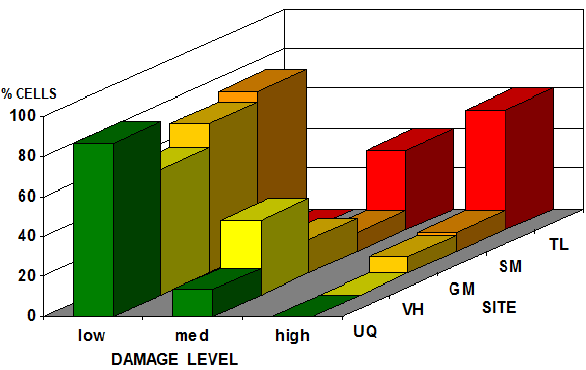
Figure 1 : Genotoxic damage to the DNA of the studied populations. Vertical axe represent the fraction of cells per subject with genotoxic damage. Horizontal axe represent 3 levels of genotoxic damage according to values of the ratio Tail/Head. Z axe represent the site of